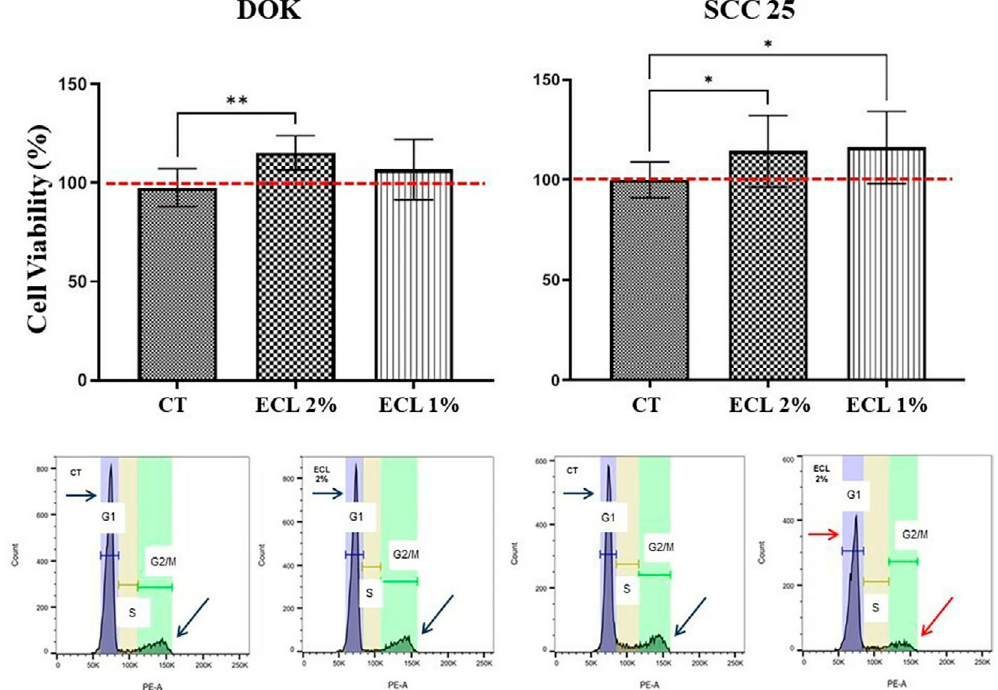
Figure 3- Cell viability and cell cycle profile. The MTT assay assessed cell viability (n=12). (A) Cell viability assay for DOK cells. A statistical difference between the group exposed to ECL 2% (v/v) and the control (**p<0.01) was found. (B) Cell viability assay for SCC 25 cells. A statistical difference between both groups exposed to ECL and the control (*p<0.05) was found. The cell cycle assay of DOK cells (n=3) (a) showed no tendency to change the cell cycle profile between CT and ECL (blue arrows). SCC 25 cells (n=3) (b) showed a tendency to disturb the cell cycle profile, with a G1 phase enlargement and a G2/M phase flattening, without statistical significance (n=3), comparing the CT (blue arrow) and ECL (red arrow)